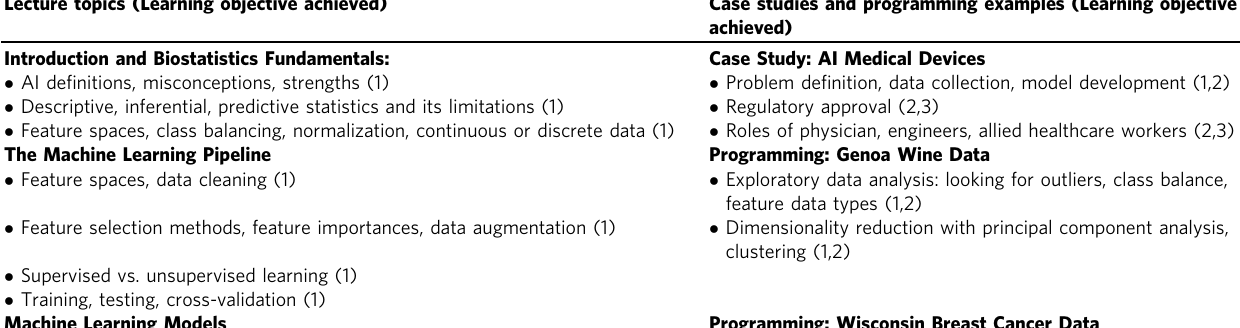
Table 1 A summary of concepts taught for each session of the fi nal iteration of the workshop. Lecture topics (Learning objective achieved) Case studies and programming examples (Learning objective achieved)